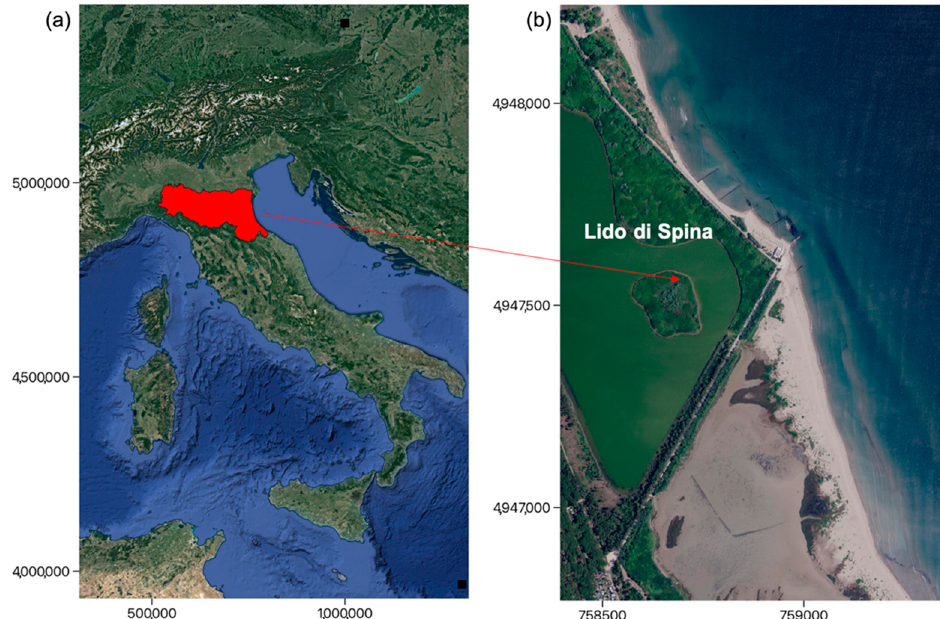
Figure 1. Lido di Spina beach ( b ) located between Porto Corsini and Porto Garibaldi, in the northern Adriatic coast of Emilia-Romagna ( a ). Base map from Agea orthophoto 2018 (https://geoportale.regione.emilia-romagna.it/servizi/servizi-ogc/elenco-capabilities-dei-servizi-wms#b, accessed on 20 July 2021) and Google satellite.